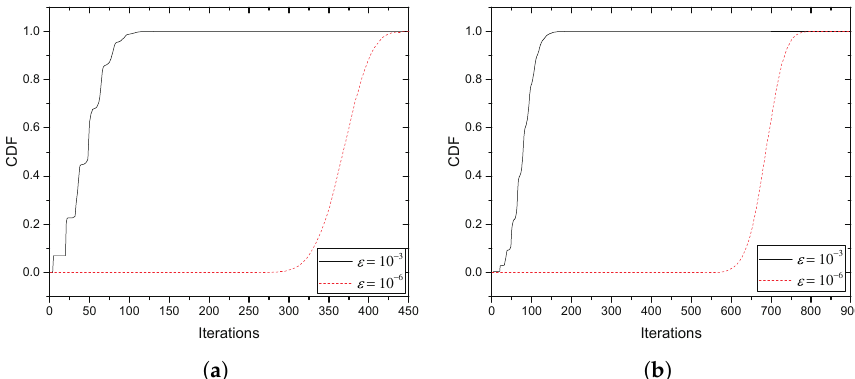
Figure 9. CDF of the number of iterations required for convergence of ICSP: ( a ) 20 jammers ( b ) 40